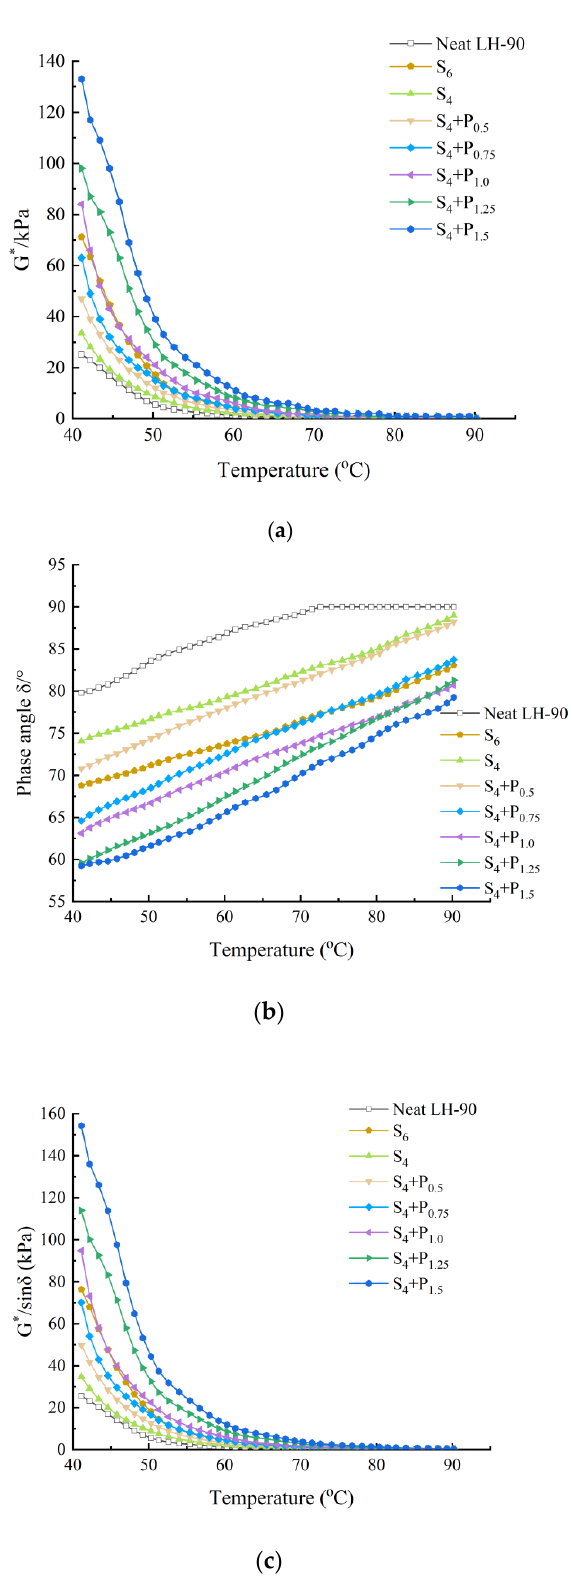
Figure 2. High-temperature properties of compound ratio of PPA – SBS and LH – 90# neat asphalt: ( a ) Complex modulus-temperature results; ( b ) Phase angle-temperature results; ( c ) G*/sinδ -tenperature results.